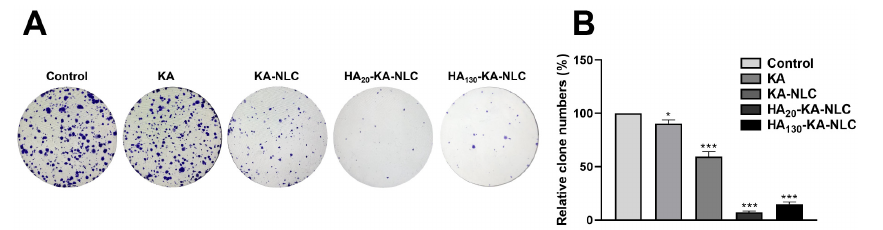
Figure 9. Clone formation assay conducted on A549 cells without treatment or with KA, KA-NLC, HA 20 -KA-NLC, and HA 130 -KA-NLC treatments. ( A ) Representative images of clone formation assays. ( B ) Relative clone numbers after different treatments. The data are presented as the mean ± SD ( n = 3). * p < 0.05, *** p < 0.001.